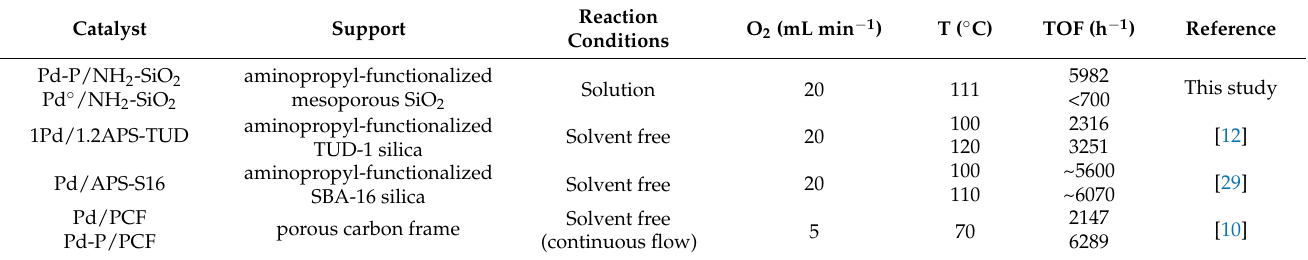
Table 7. TOF Comparison for Pd-P/NH 2 -SiO 2 and other catalysts in the